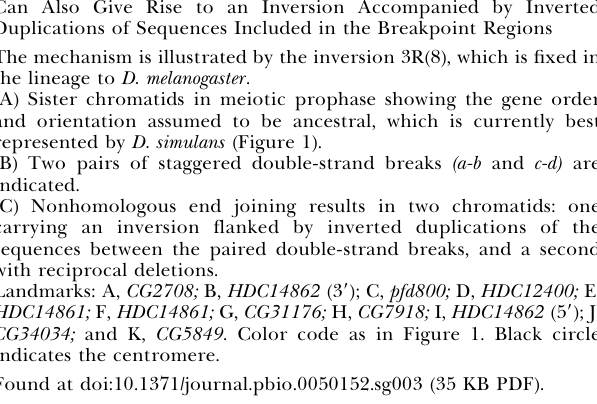
CG34034, and the HDC14862 (5 9 ) sequence. These events illustrate the complexity of some inversion breakpoint regions as a consequence of events that occur subsequent to the original inversion. Color code as in Figure 1. For the sake of simplicity, two putatively expressed genes (HDC12142 and HDC12143) and insertions of repetitive sequences have not been included. Found at doi:10.1371/journal.pbio.0050152.sg002 (28 KB PDF). Figure S3. A Chromatid Model with Staggered Double-Strand Breaks Can Also Give Rise to an Inversion Accompanied by Inverted Duplications of Sequences Included in the Breakpoint Regions The mechanism is illustrated by the inversion 3R(8), which is fixed in the lineage to D. melanogaster . (A) Sister chromatids in meiotic prophase showing the gene order and orientation assumed to be ancestral, which is currently best represented by D. simulans (Figure 1). (B) Two pairs of staggered double-strand breaks (a-b and c-d) are indicated. (C) Nonhomologous end joining results in two chromatids: one carrying an inversion flanked by inverted duplications of the sequences between the paired double-strand breaks, and a second with reciprocal deletions. Landmarks: A, CG2708; B, HDC14862 (3 9 ); C, pfd800; D, HDC12400; E, HDC14861; F, HDC14861; G, CG31176; H, CG7918; I, HDC14862 (5 9 ); J, CG34034; and K, CG5849 . Color code as in Figure 1. Black circle indicates the centromere. Found at doi:10.1371/journal.pbio.0050152.sg003 (35 KB PDF). Figure S4. Large-Scale Comparison of the Muller’s Elements A, D, and E between D. melanogaster and D. yakuba (A), Muller’s element A (chromosome X); (B) Muller’s elements D and E (chromosome 3). The outermost protein-coding genes of consec- utive syntenic blocks are indicated. Following [116], syntenic blocks (defined as regions in which the relative gene order is globally conserved between D. melanogaster and D. yakuba ) are numbered taking D. melanogaster as a reference and in an increasing order from the telomere of chromosome X (number 1) to the telomere of the right arm of chromosome 3 (number 58); an arrowhead indicates the orientation of the segments. Lines between chromosomes match homologous syntenic blocks between species. Solid triangles corre- spond to genes that were duplicated during the generation of inversions in the lineage that leads to D. yakuba following a model of staggered strand breaks (Figures 2, S2, and S3). Those genes are CG14187, which was generated by the inversion X(1) in (A), and CG34034, which was generated by the inversion 3R(7) in (B). Open triangle denotes gene CG9925, whose relocation can be explained by a conservative transposition event or, alternatively, by two paracentric inversions that overlap by one gene, CG9925 . The fact that CG9925 is flanked both in D. melanogaster and D. yakuba by genes that, in their turn, are the outermost markers of different syntenic blocks strongly supports the second explanation. Found at doi:10.1371/journal.pbio.0050152.sg004 (34 KB PDF). Figure S5. Different Evolutionary Scenarios That Can Lead to the Presence of Inversion-Mediated Duplications at Only One of the Two Co-occurrent Breakpoint Regions The inversion X(1) is used as an example. D. melanogaster (top gene configuration) and D. yakuba (bottom gene configuration). (A) Scenario involving four staggered breakpoints (arrows). In this case, the duplication of CG14817 and HDC18578 is coupled with the generation of the inversion. Subsequently, one of the copies of HDC18578 degenerates by accumulating nucleotide substitutions and indels so that it is no longer recognizable. (B) Scenario involving staggered breakpoints at one genomic region and a single-strand break at the other. In this case, only CG14817 becomes duplicated as a result of the inversion. The outcome of both scenarios is identical. Coding sequences that have undergone an inversion-mediated duplication in the lineage that leads to D. yakuba, CG14817 (in green) and HDC18578 (in pink) are indicated by a gradient. C, centromere; T, telomere. Found at doi:10.1371/journal.pbio.0050152.sg005 (25 KB